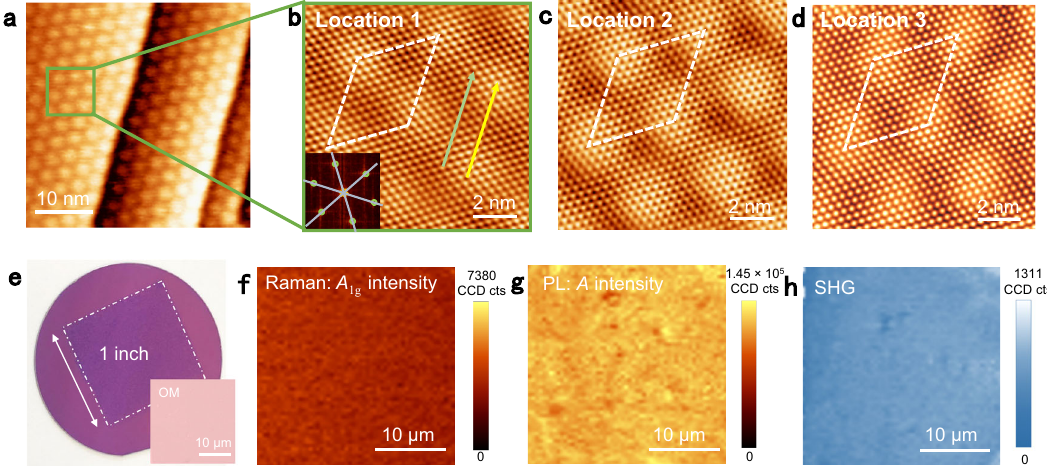
Fig. 5 Single-crystal property characterizations of the continuous monolayer MoS 2 fi lm achieved by the growth and merging of monolayer MoS 2 ribbons. a Large-area STM image ( V Tip = – 0.61 V, I Tip = 3.55 nA) of the monolayer MoS 2 fi lm on the Au(223) facet with Au(111) terrace. b Magni fi ed STM image ( – 0.1 V, 30.77 nA) of the green square region in ( a ), presenting the perfect alignment of MoS 2 lattice direction with moiré row direction, as denoted by green and yellow arrows, respectively. Inset: corresponding 2D-FFT pattern. c , d Representative atomically resolved STM images of the moiré pattern for MoS 2 /Au(111), presenting a fi xed period of ∼ 3.21 ± 0.10 nm (marked by white rhombus; − 0.10 V, 40.95 nA; − 0.1 V, 32.79 nA). e Photograph and corresponding OM image of a 1-inch single-crystal MoS 2 fi lm transferred on SiO 2 /Si. f Raman mapping on the A 1g peak intensity for the monolayer MoS 2 single crystal showing a uniform color contrast. g PL mapping on the A exciton intensity of the monolayer fi lm. h SHG mapping of the monolayer MoS 2 single